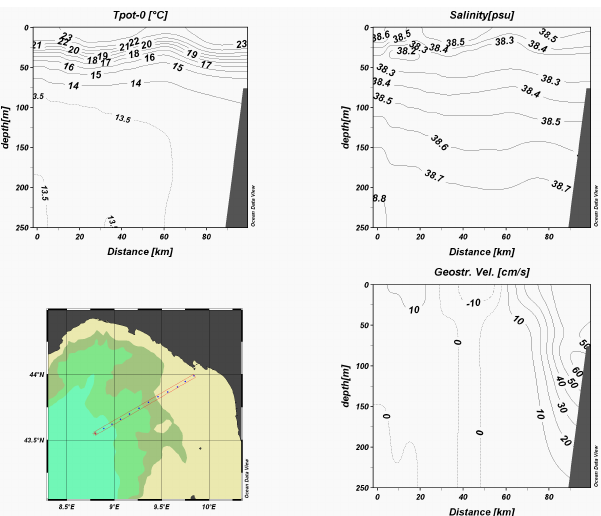
Fig. 5. CTD transect between the Ligurian coasts and the mooring location taken on 11th of September 2003. Dotted lines indicate the location of CTD profiles. Potential temperature, salinity and computed geostrophic currents evidence the mesoscale structures associated to the front.